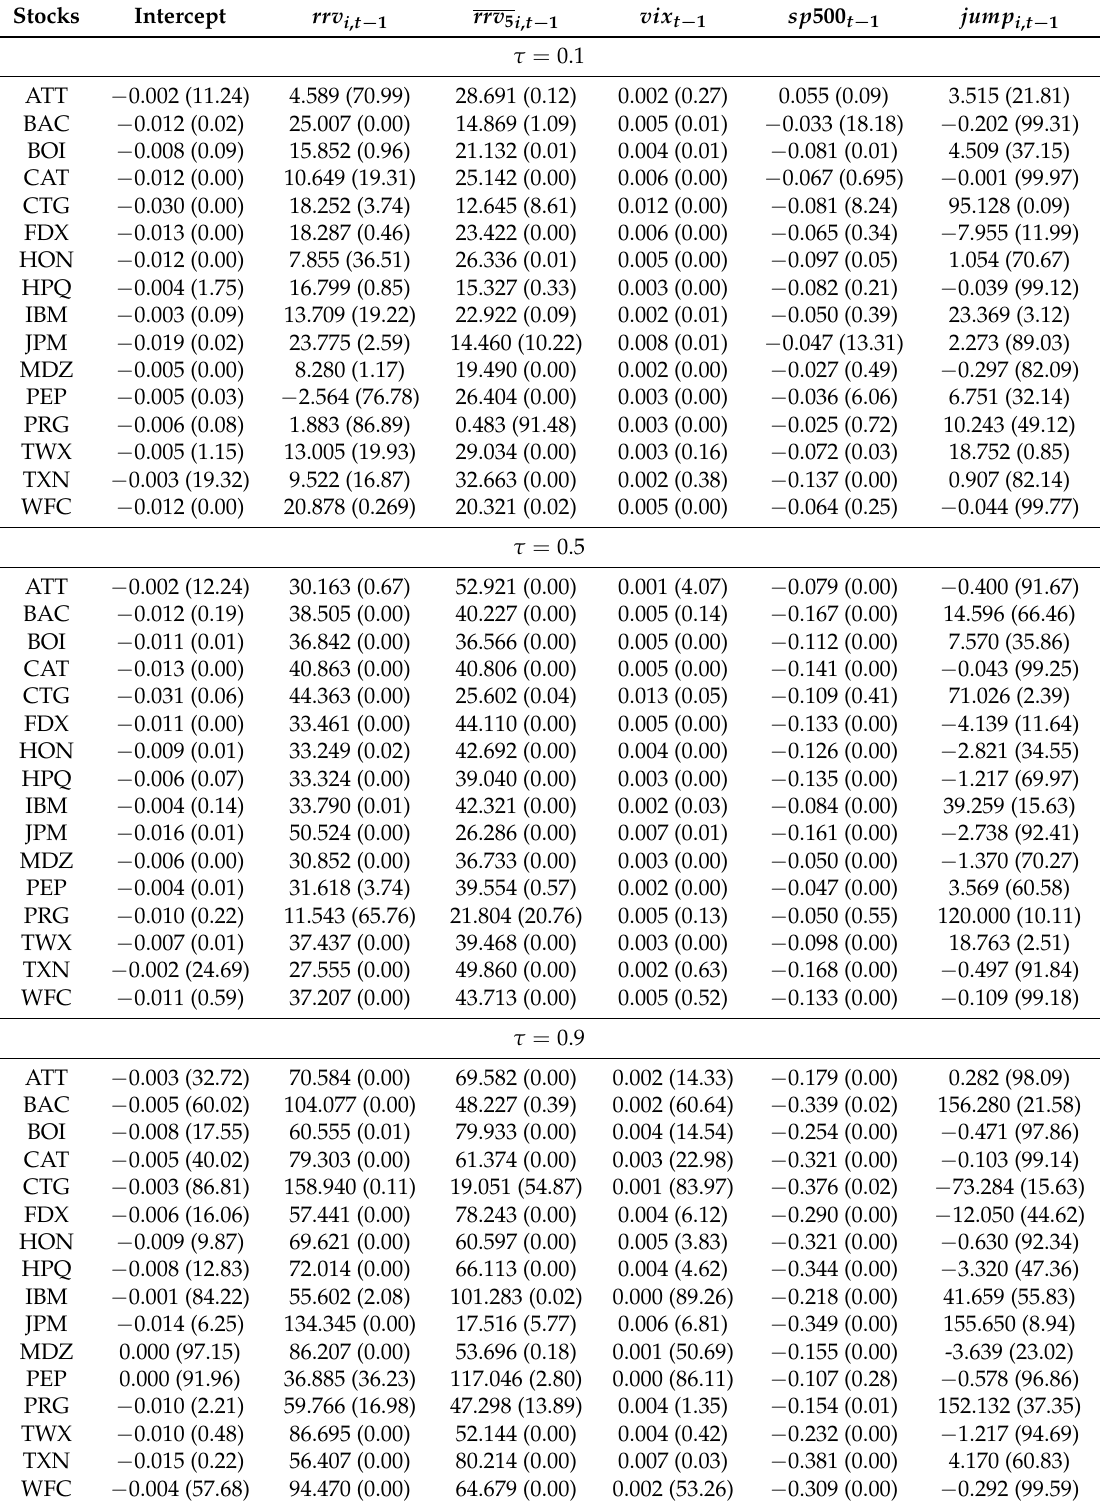
Table 3. Quantile regression results for each